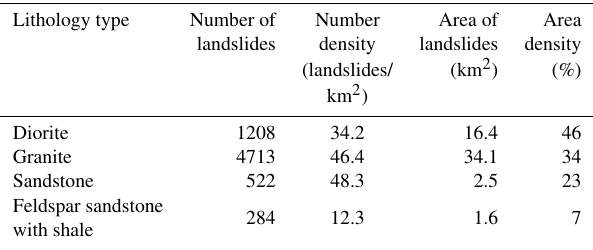
Table 3. The relation between lithology and co-seismic landslides. Table 4. Co-seismic landslide types.